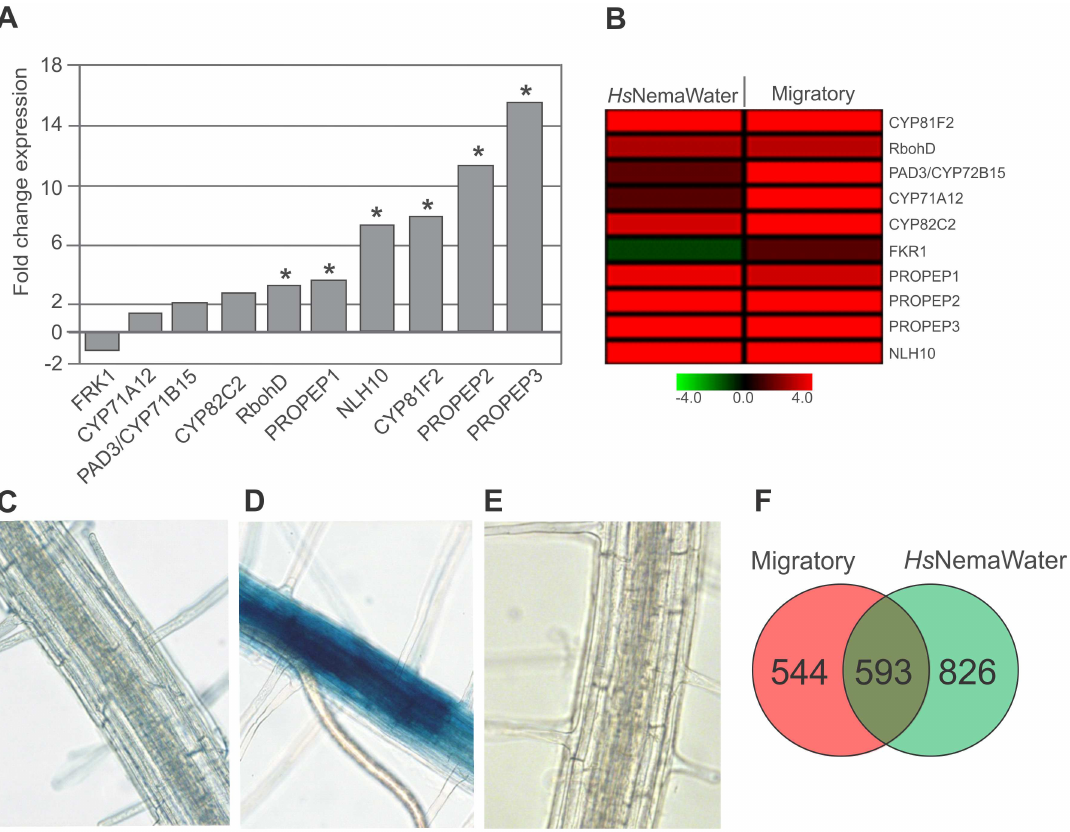
Fig 2. NemaWater treatment induced defense responses in plants that are characteristics of PTI. (A) Expression of PTI marker genesin microarray analysisupon Hs NemaWater treatment. Root segmentsfrom uninfectedroots were used as control. Asterisk indicatessignificantdifference to control (FDR < 0.05; Fold change > 1.5). ( B ) A heatmapshowingexpression of PTI marker genesupon nematodeinfectionor upon Hs NemaWater treatment. ( A-B ) Values represent fold change comparedwith control. ( C-E ) Expression of glucuronidase(GUS) driven by pCYP71A12 in control (C), H . schachtii infectionat migratory stage (D) and Hs NemaWater treated plants (E) ( F ) A Venn diagram showingdistribution of upregulatedgenes in Arabidopsis upon nematodeinfectionor upon Hs NemaWater